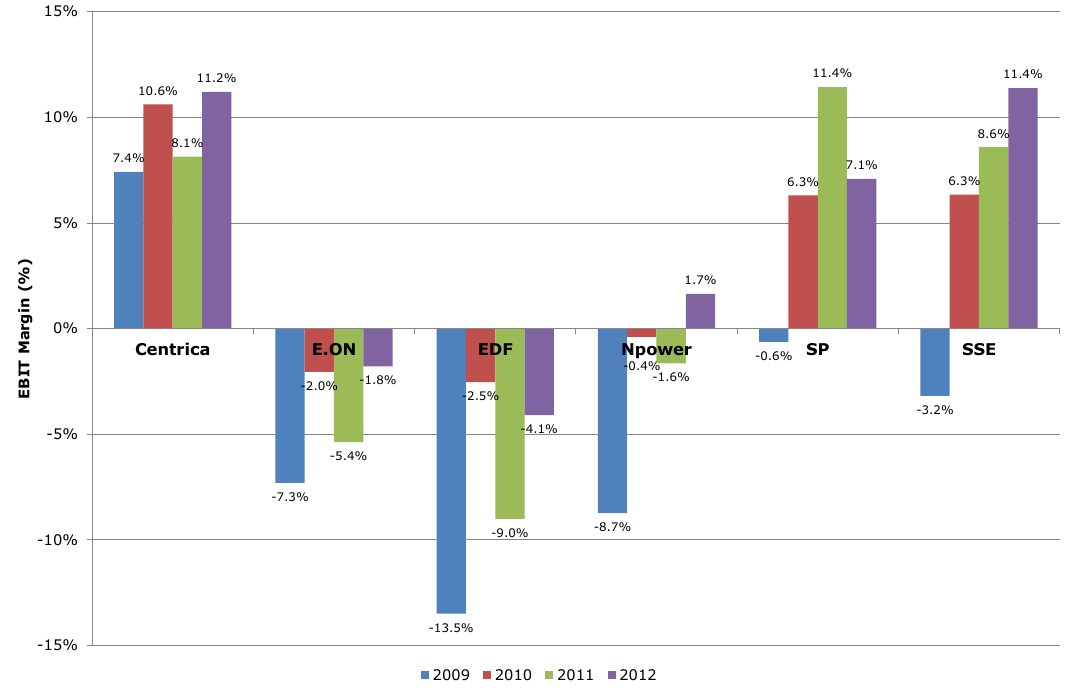
Figure 49: Six largest suppliers Domestic Gas Supply EBIT Margins (% of